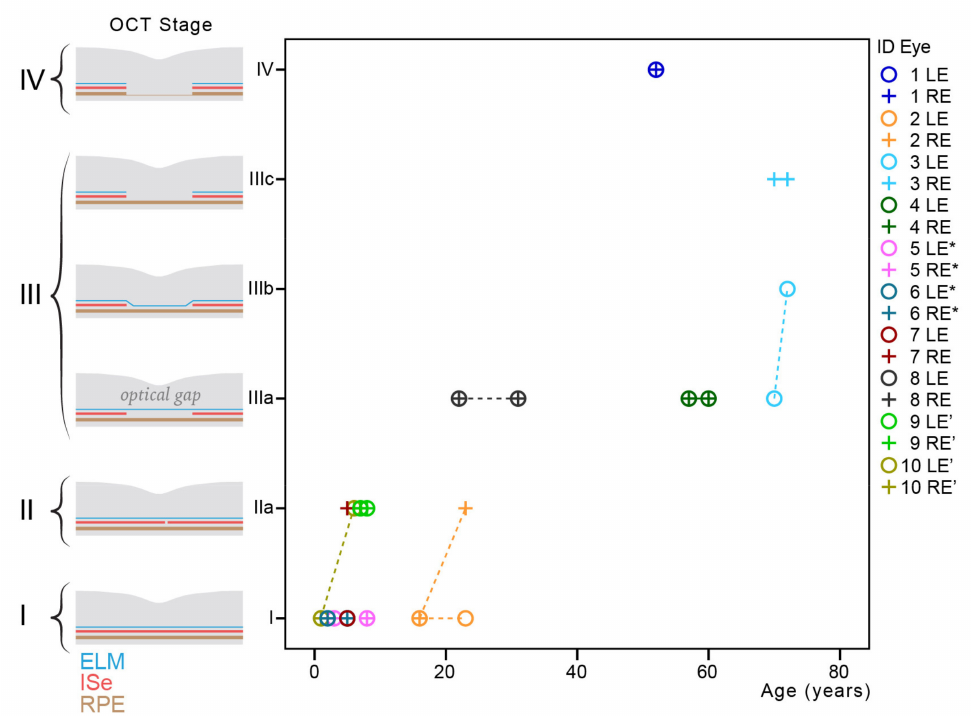
Figure 3. OCT features in relation to age. Chart showing OCT features in relation to age. Follow-up data are shown with interpolation lines. Note also good inter-eye symmetry. Patients from the same families are marked with * and ’